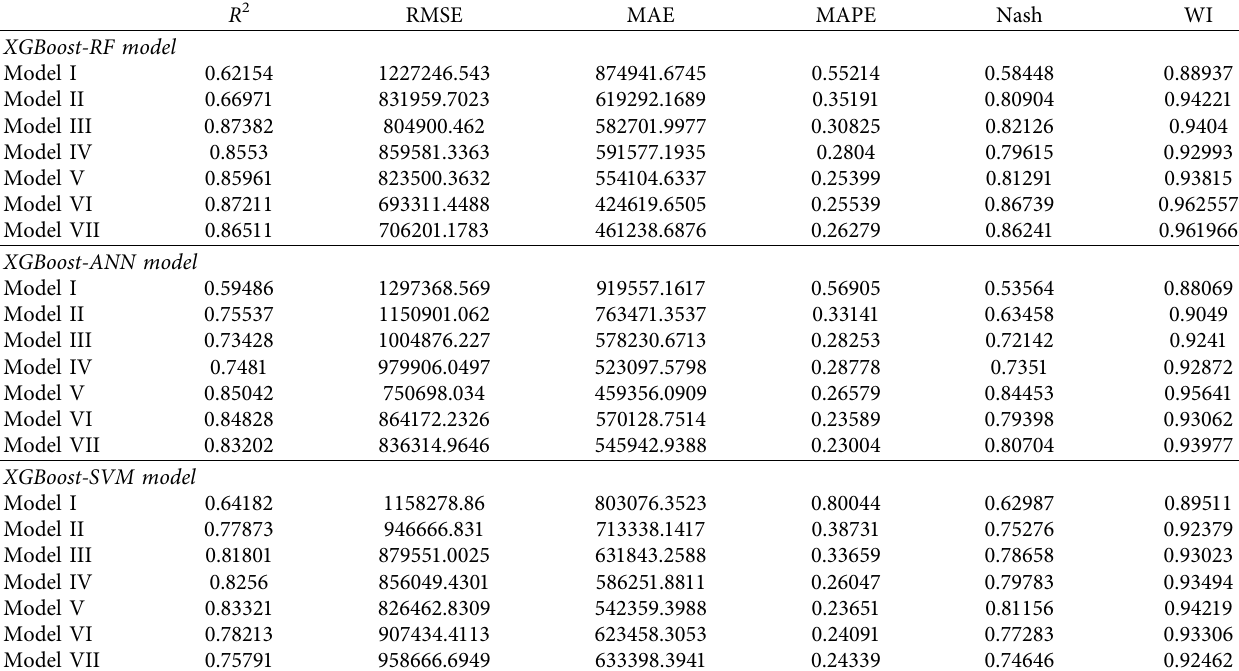
Table 4: Performance measures of AI models for testing